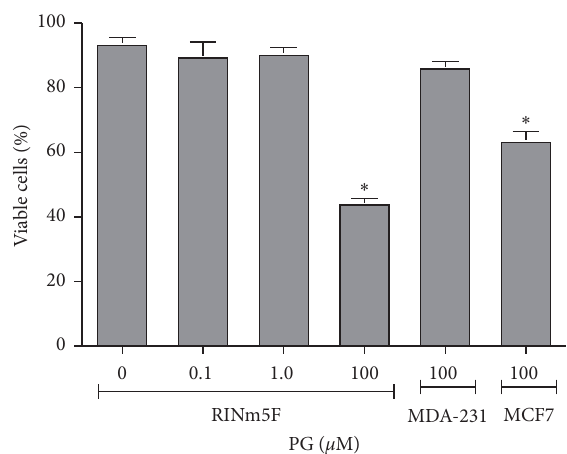
Figure 1: Cell viability upon progesterone treatment. RINm5F cells were analyzed by flow cytometry after incubation with 0.1, 1.0, or 100 μ M progesterone or absolute ethanol (control) by 24h, and 10,000 events were analyzed per sample. Data are presented as means ± SEM of three experiments in duplicates. ∗ indicates difference in comparison to control. PG: progesterone; MDA-MB- 231: negative control; MCF7: positive control for progesterone receptors